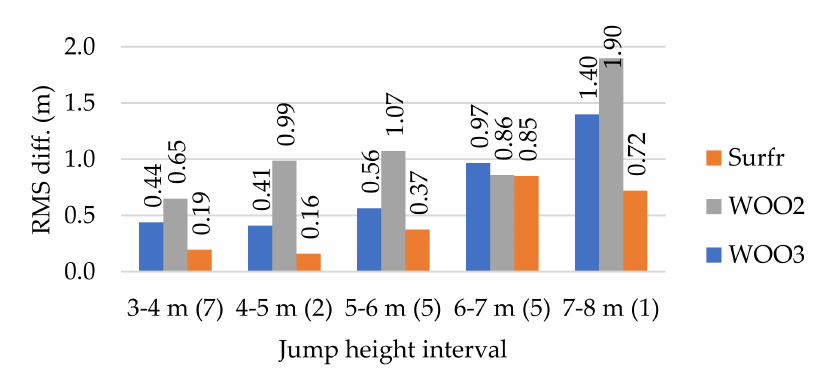
Figure 12. Accuracy of wearable sensors according to jump height. The number of jumps in each group is given in parentheses after the height